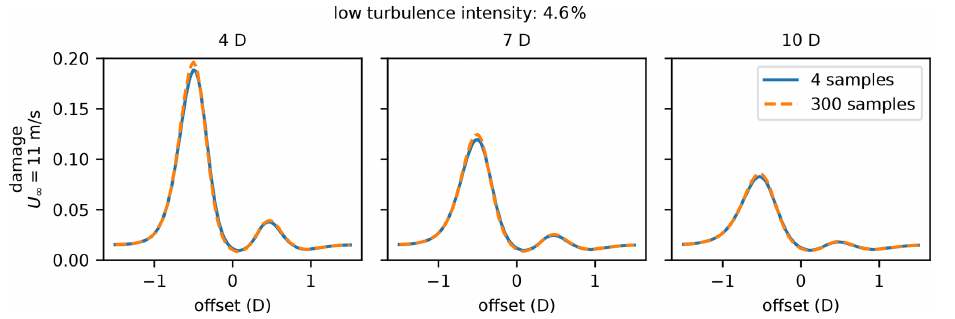
Figure 7. Final damage plots calculated with different numbers of rotor samples to determine the average wind speed across the rotor. The blue line represents damage calculated with 4 sample points; the orange line represents the damage calculated with 300 sample points. Notice they are almost